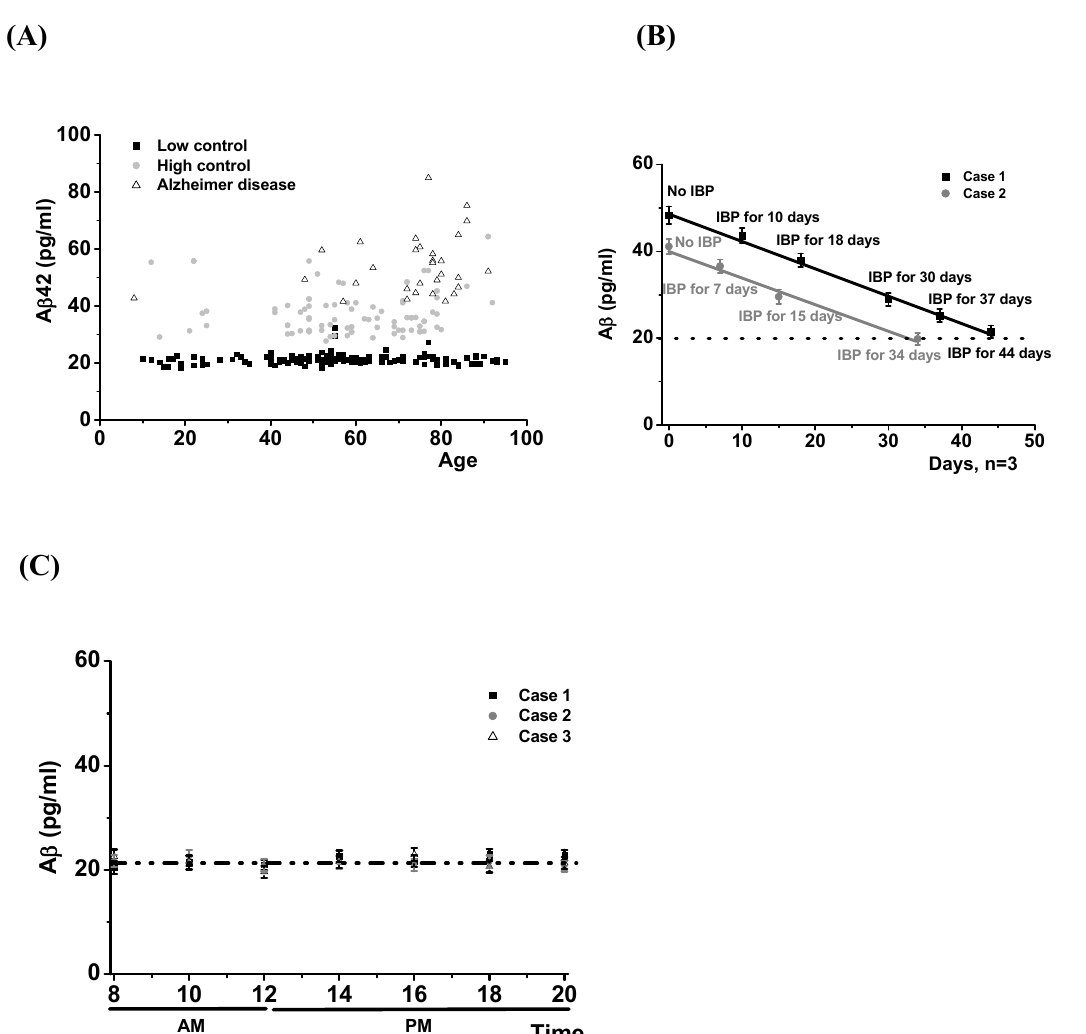
Figure 2. ( A ) Abeta42 levels in the saliva of 148 normal, 89 high normal (at risk), and 30 AD cases. A β levels of low controls, high controls, and AD were tested. Averages and SD were 21.26 ± 1.73 for